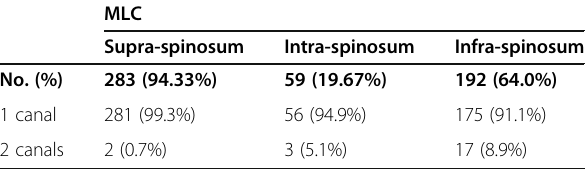
Table 3 Distribution of